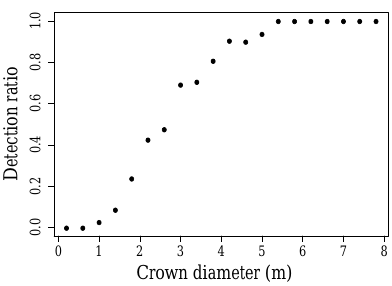
Figure A2. Detection ratios of woody plants in classified imagery at field work sites. The values were calculated as mean detection ratios for trees divided into bins of width